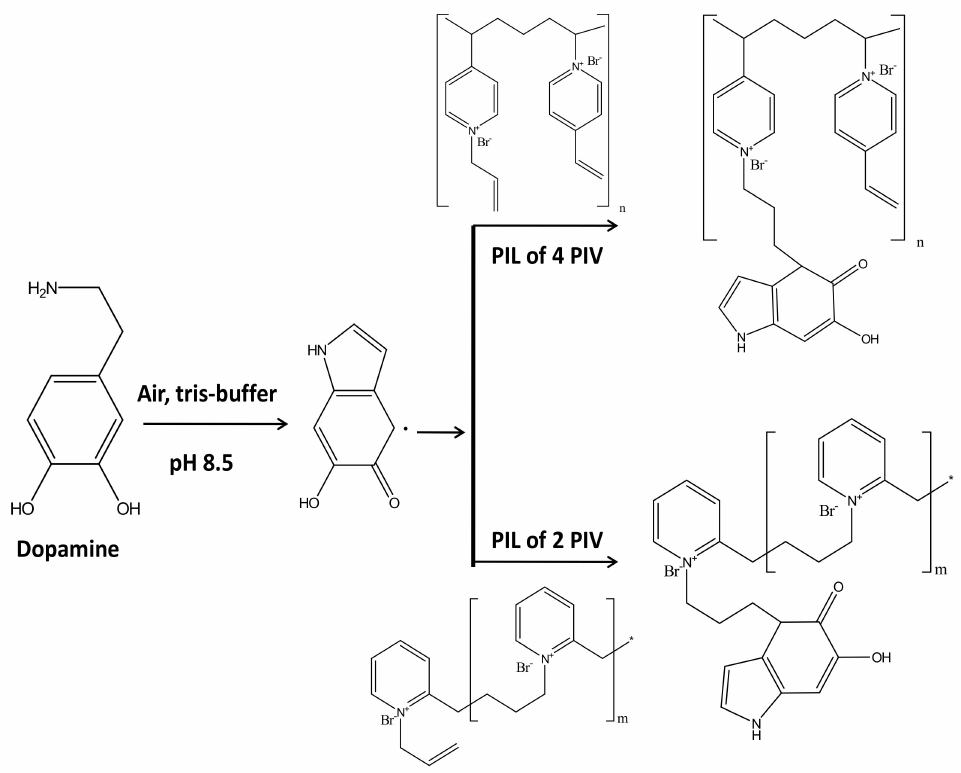
Figure 2. The schematic presentation of fabrication of active surface layer.